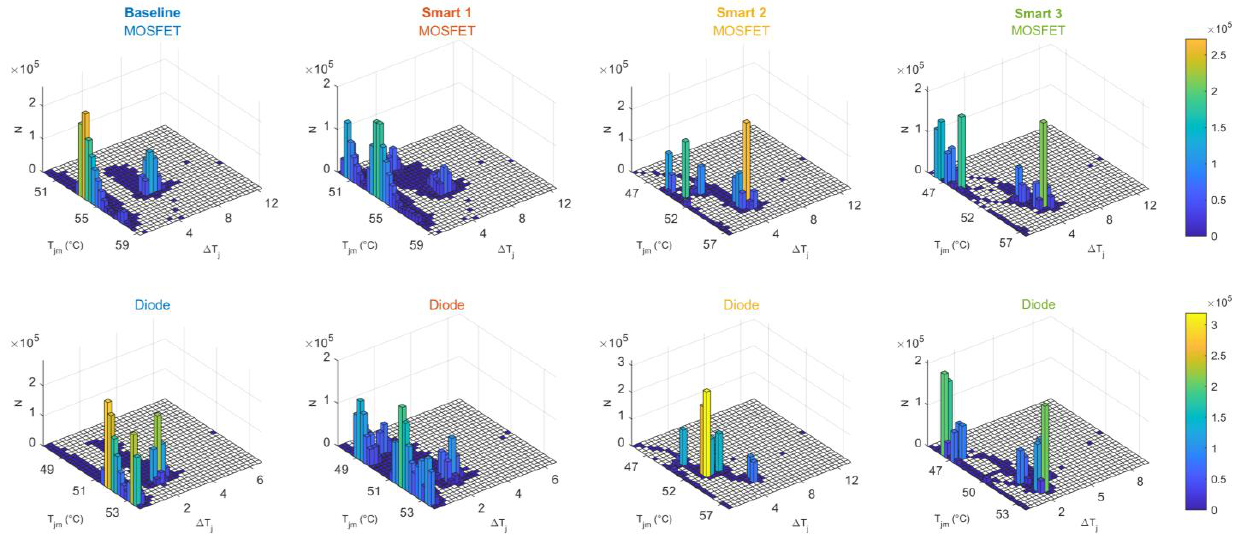
Figure 8. Results of the rainflow cycle counting algorithm for the considered charging current pro-